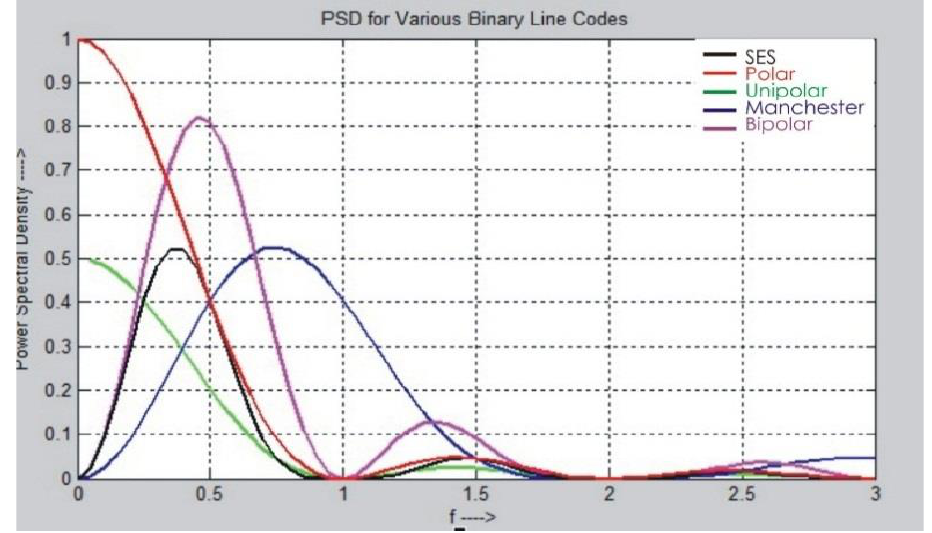
Figure 10. SES vs. Various line codes.